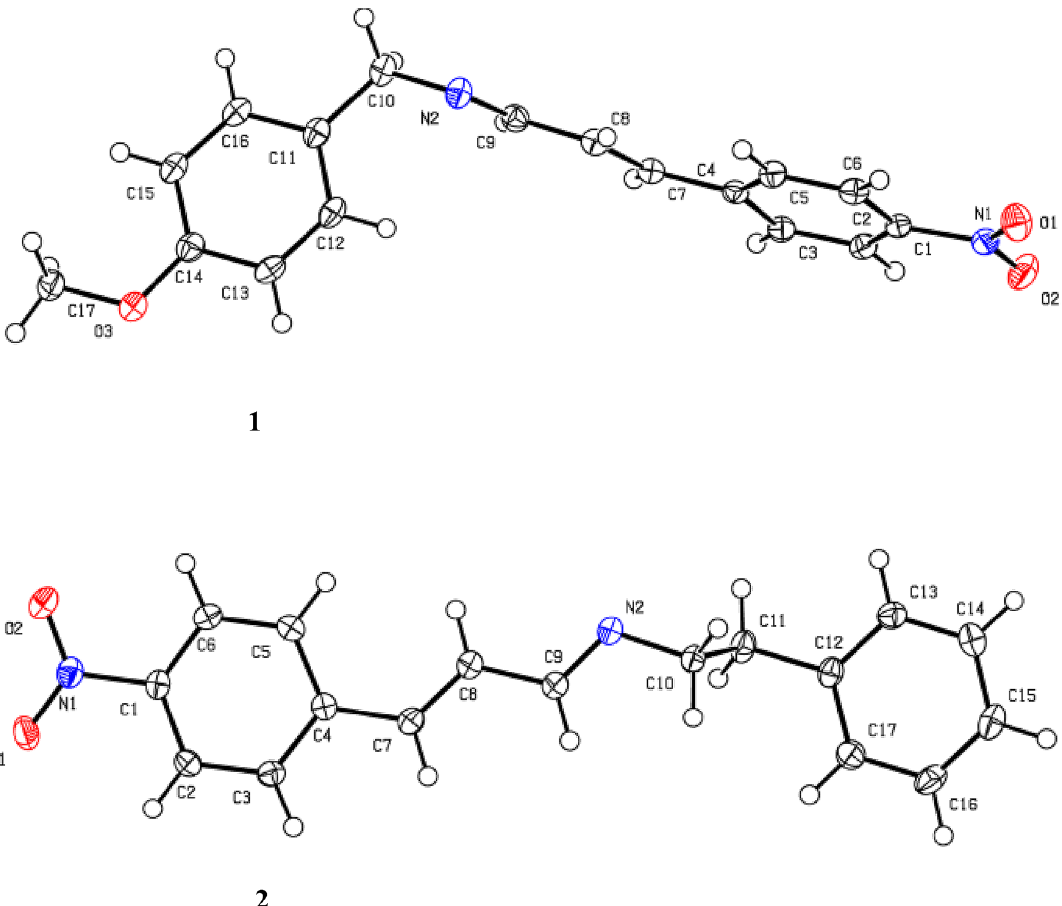
Figure 1. Crystal structures of the compounds with atom labelling (thermal ellipsoid, 50%).